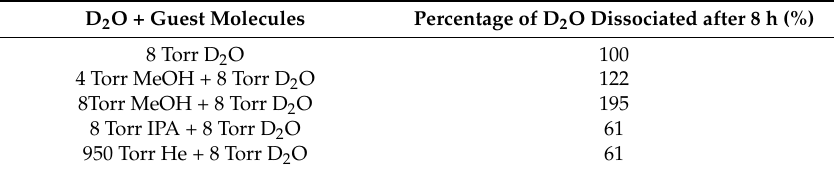
Figure 1. ( a ) Infrared spectra of Zn-MOF-74 impregnated with the different alcohol mixtures (methanol = Me and Isopropyl alcohol = IPA) for 8 h at 180 °C, compared to a He/D 2 O mix and pure D 2 O previously reported [14]. ( b ) Kinetic plots of the dissociation reaction over time (integrated area of 970 cm − 1 band). All spectra are normalized to metal organic frameworks (MOF) quantity. Table 1. Percentage of deuterated water dissociated after 8 h of reaction for D 2 O + guest molecules, based on data shown in Figure 1b, compared to pure D 2 O (taken as the reference, i.e., 100%). D 2 O + Guest Molecules Percentage of D 2 O Dissociated after 8 h